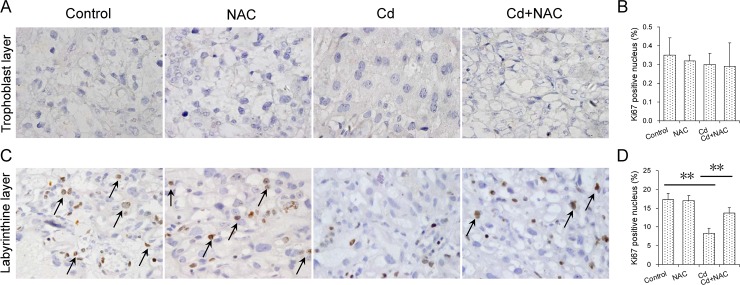
Effects of NAC on Cd-induced inhibition of placental cell proliferation.All pregnant mice except controls were i.p. injected with CdCl2 (1.0 mg/kg) daily from GD13 to GD17. In NAC+Cd group, pregnant mice were i.p. injected with NAC (1.0 g/kg) daily from GD12 to GD17, one dose (300 mg/kg) at 8 h before CdCl2 injection, one (400 mg/kg) at 30 min before CdCl2 injection, another (300 mg/kg) at 8 h after CdCl2 injection. Placentas were collected on GD 18. Placental cell proliferation was observed in Ki67 immunohistochemically stained placental sections. Sections were counterstained with hematoxylin. Arrows indicate Ki67-positive cells. (A) Placental cross section from trophoblast layer. (B) Percentage of Ki67-positive cells. (C) Placental cross section from labyrinthine layer. (D) Percentage of Ki67-positive cells. All data were expressed as means ± SEM. (N = 6). **P<0.01.